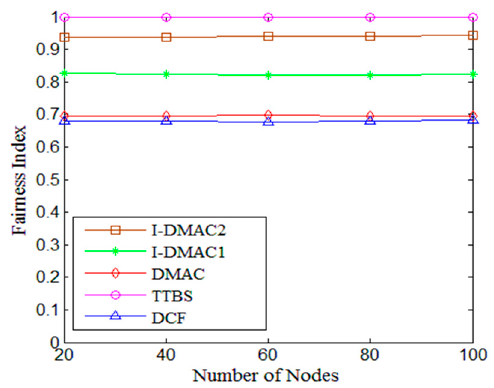
Figure 8. Fairness index under multi-rate scenario.